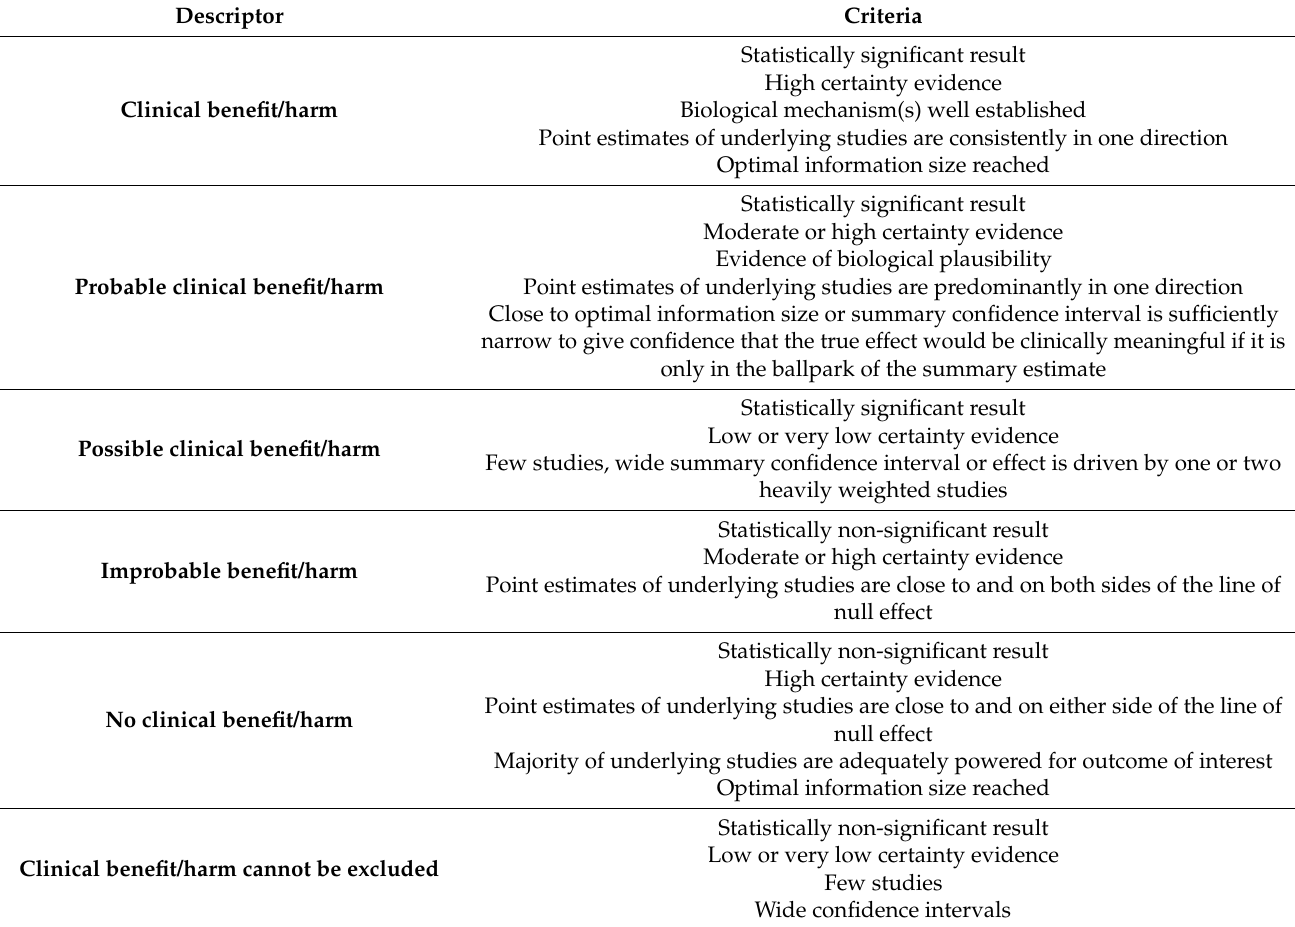
Table 1. Statements to communicate the findings of the systematic